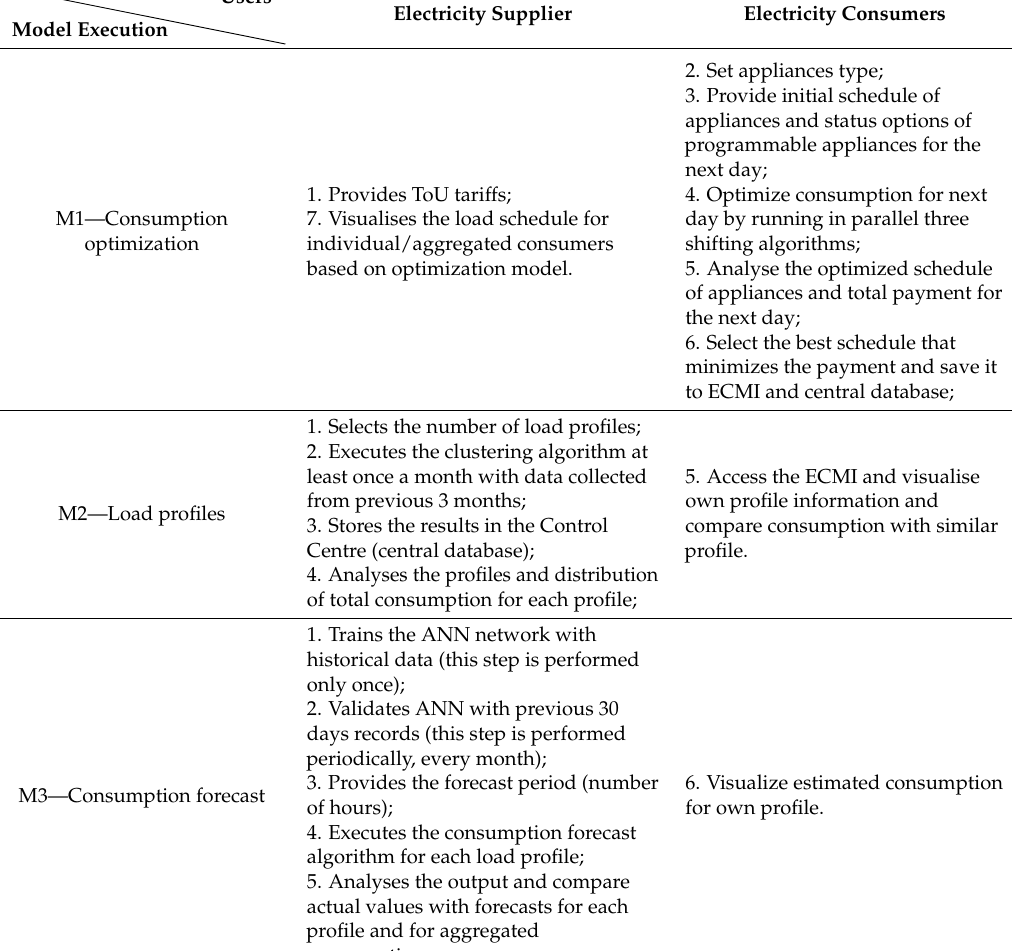
Table 1. Interaction between users and